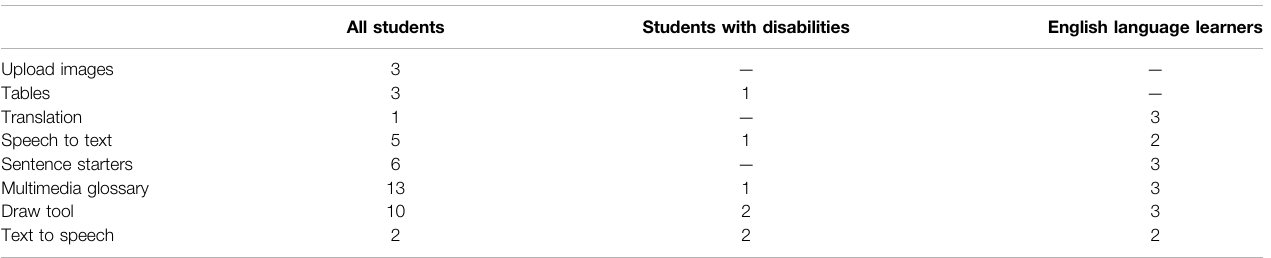
TABLE 8 | Teachers reporting positive impact of SNUDLE Features on Students (n (cid:1) 17